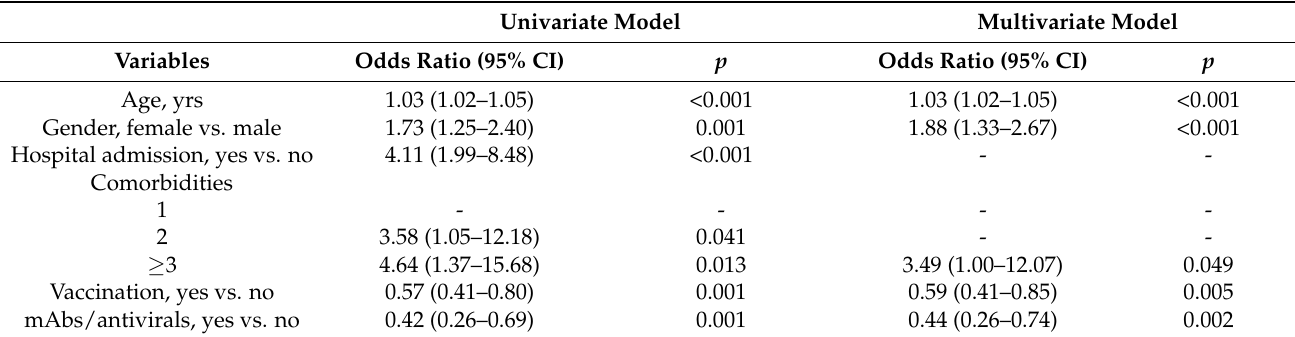
Table 2. Logistic regression analysis for long COVID